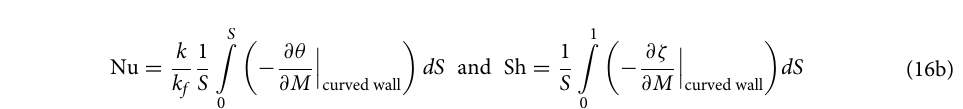
Figure 4. Oxygen isoconcentration ( ζ ) for different geometric cavity at Le = Pe = 1, Gr = 10 4 , Da = 10 –3 , Ha = 30 for square, trapezoidal and W-shaped